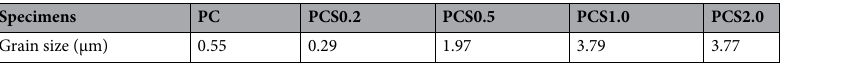
Table 2. Average grain sizes of various Cu electroplated samples determined by the EBSD grain mappings in Fig. 5.